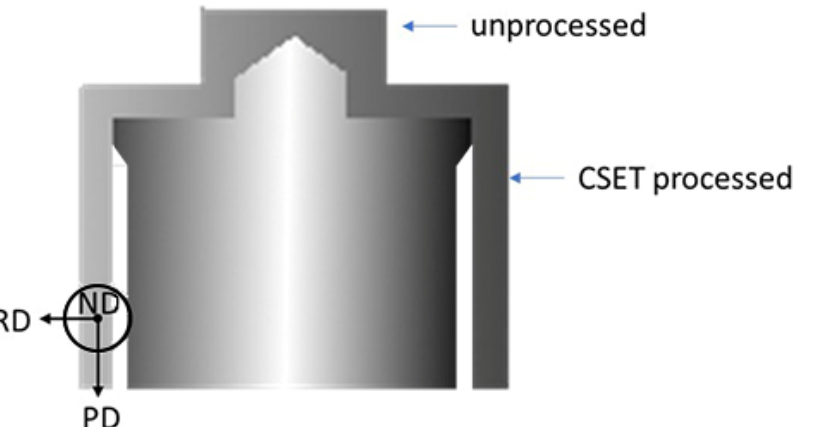
Figure 2. Schematic depiction of the cross section of the CSET processed sample and definition of the directions: PD—pressing direction, ND—normal direction, RD—radial direction.